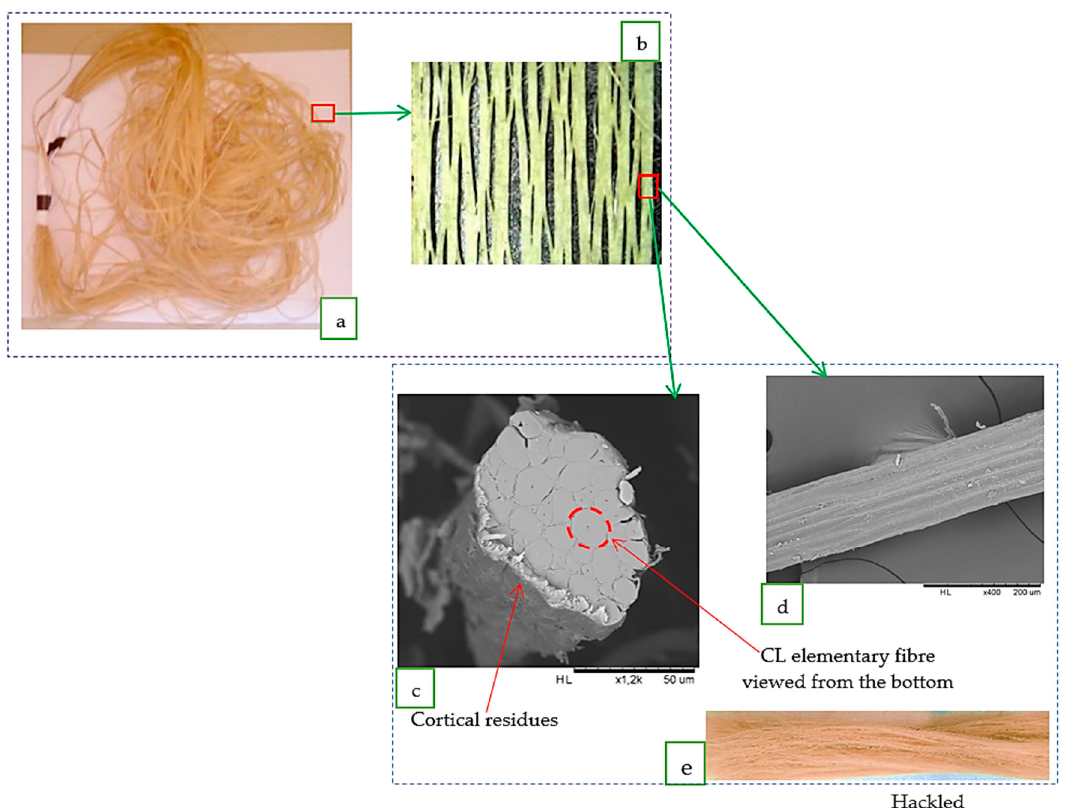
Figure 2. Multi ‐ scale structure of CL fibers: ( a ) CL fibers ribbons; ( b ) longitudinal view of CL fibers ribbons by Optical microscope; ( c ) SEM Cross section view CL fibers bundle; ( d ) SEM longitudinal view of CL fibers bundle; ( e ) hackled CL fibers bundles .